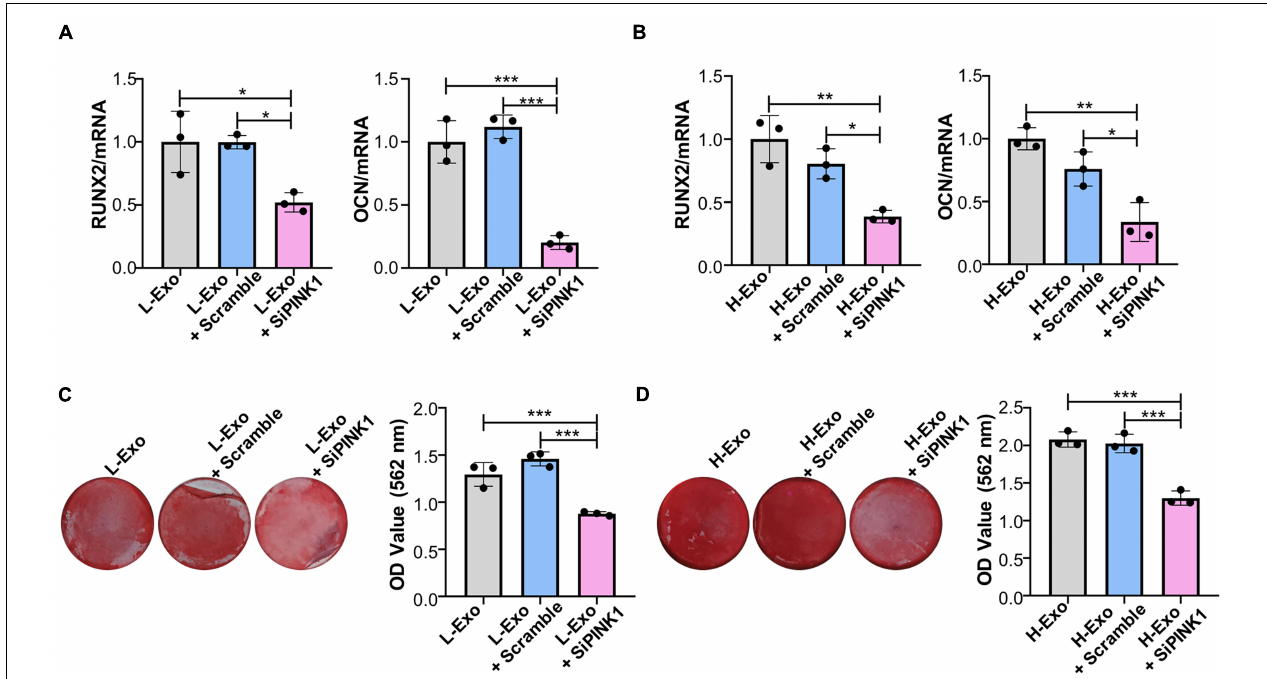
FIGURE 5 | H-Exo and L-Exo promoted the osteogenic differentiation of TCs through PINK1/Parkin-mediated mitophagy. (A) Osteogenic inducing fluid containing 20 µ g/ml exosomes was used, and the expression levels of the osteogenic differentiation-related genes in the TCs without transfection or transfected with scrambled siRNA or PINK1 siRNA and with L-Exo stimulation were determined by RT-qPCR after 7 days of osteogenic induction ( n = 3). (B) Osteogenic inducing fluid containing 20 µ g/ml exosomes was used, and the expression levels of osteogenic differentiation-related genes in the TCs without transfection or transfected with scrambled siRNA or PINK1 siRNA and with H-Exo stimulation were determined by RT-qPCR after 7 days of osteogenic induction ( n = 3). (C) Osteogenic inducing fluid containing 20 µ g/ml exosomes was used, and mineralization nodule formation in the TCs without transfection or transfected with scrambled siRNA or PINK1 siRNA and with L-Exo stimulation was tested by Alizarin red staining after 28 days of osteogenic induction ( n = 3). (D) Osteogenic inducing fluid containing 20 µ g/ml exosomes was used, and mineralization nodule formation in the TCs without transfection or transfected with scrambled siRNA or PINK1 siRNA and with H-Exo stimulation was tested by Alizarin red staining after 28 days of osteogenic induction ( n = 3). L-Exo, exosomes secreted by L-SCCs; L-Exo + scramble, TCs transfected scrambled siRNA with L-Exo stimulation; L-Exo + siPINK1, TCs transfected PINK1 siRNA with L-Exo stimulation; H-Exo, exosomes secreted by H-SCCs; H-Exo + scramble, TCs transfected scrambled siRNA with H-Exo stimulation; H-Exo + siPINK1, TCs transfected PINK1 siRNA with H-Exo stimulation. * P < 0.05; ** P < 0.01; *** P <